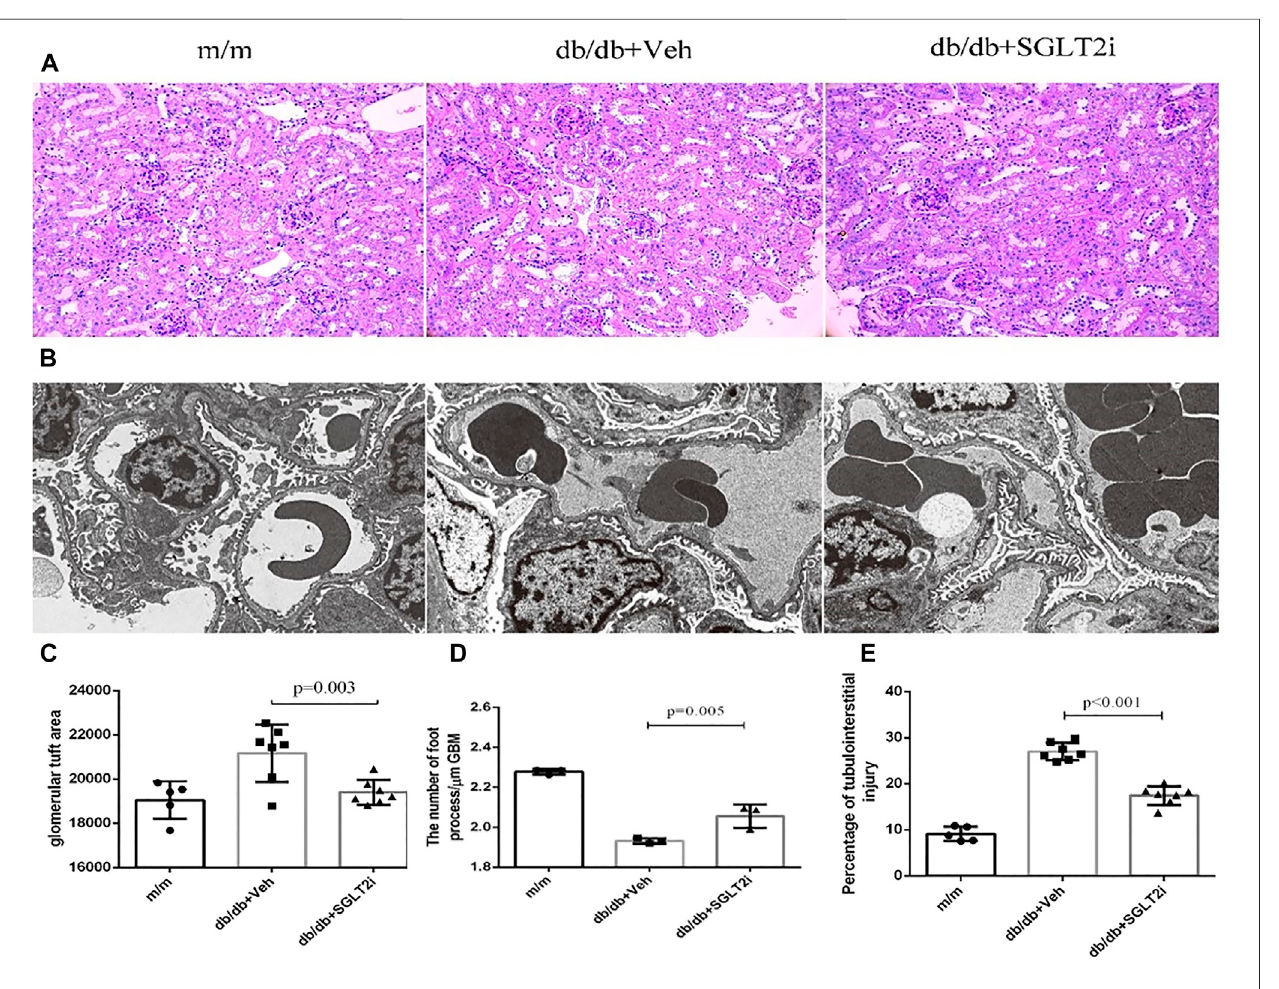
Frontiers in Pharmacology |